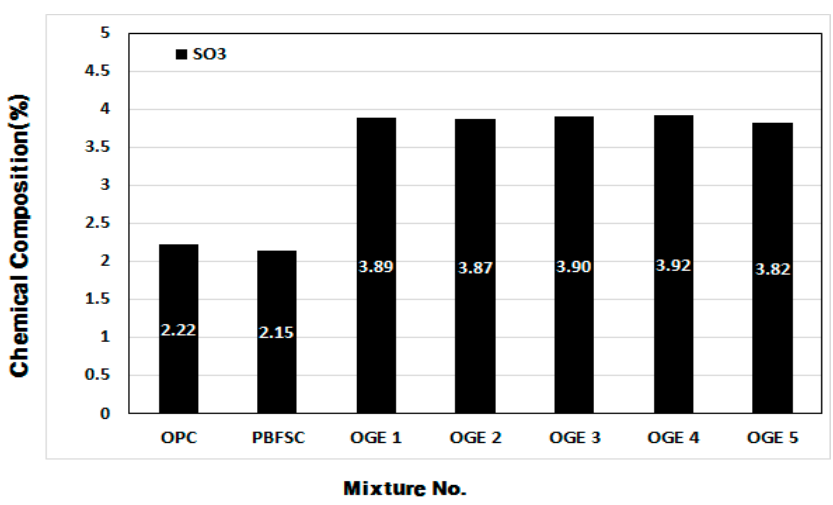
Figure 10. Scope of chemical composition (%) of SO 3 at different ESA burning temperatures.